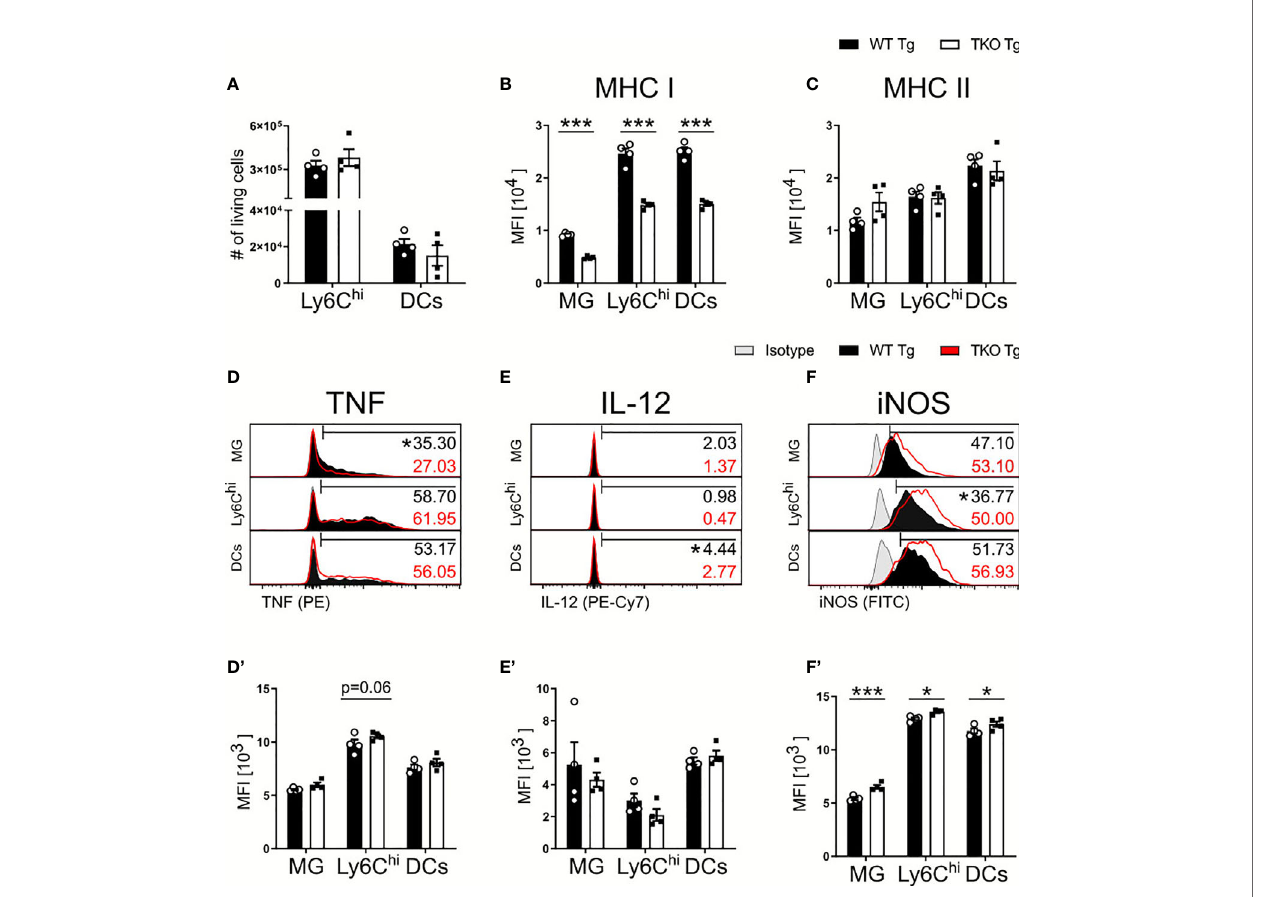
FIGURE 6 | Increased anti-parasitic immune response in brains of TKO mice in chronic stage of infection. Immune cells were isolated from brain homogenate of T. gondii infected WT (WT Tg, n=4) and TKO (TKO Tg, n=4) mice on day 28 p.i. For the measurement of TNF, IL-12 and iNOS brain cells were restimulated with TLA for 6 hours, stained and analyzed by fl ow cytometry. Following viability staining and the basic FSC/SSC gating, single cells were chosen for further characterization. Using the same gating strategy as described for Fig 2A and 5A, CD11b + CD45 int microglia (MG), CD11b + CD45 hi Ly6G - Ly6C hi in fl ammatory monocytes and CD11b + CD45 + CD11c + DCs were analyzed. (A) Total cell numbers were calculated as a percentage of live cells found in the brain for Ly6C hi monocytes and DCs. The surface expression of (B) MHC I and (C) MHC II expression was determined on MG, DCs and Ly6C hi monocytes. Histograms of the intracellular production of